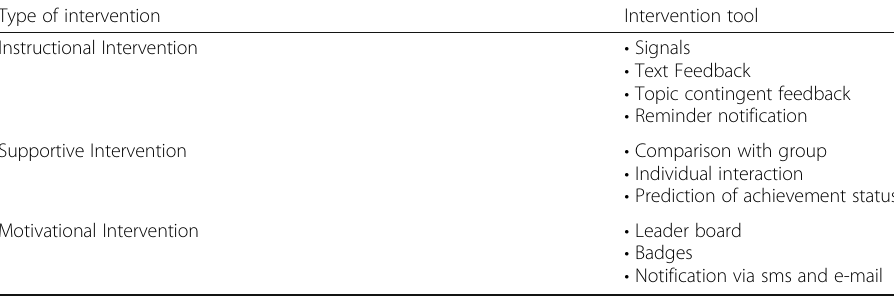
Table 3 Types of intervention and their components Type of intervention Intervention tool Instructional Intervention